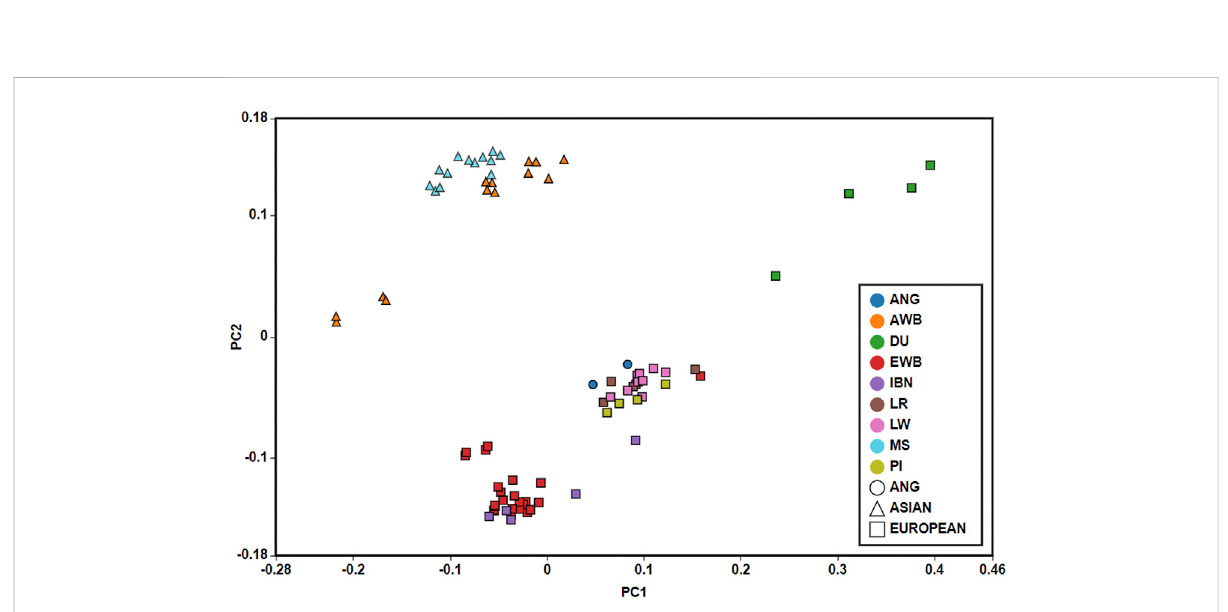
FIGURE 4 Principal Component Analysis. Eigenvectors for Principal Component Analysis show that, considering PC1 and PC2, two major clusters are formed: a cluster with Asian samples (triangle) and a mainly European cluster (square). ANG samples (circle) were clustered with European samples. IBN — Iberian; LR — Landrace; LW — Large White; DU — Duroc; PI — Pietrain; EWB — European Wild Boar; MS — Meishan; AWB — Asian Wild